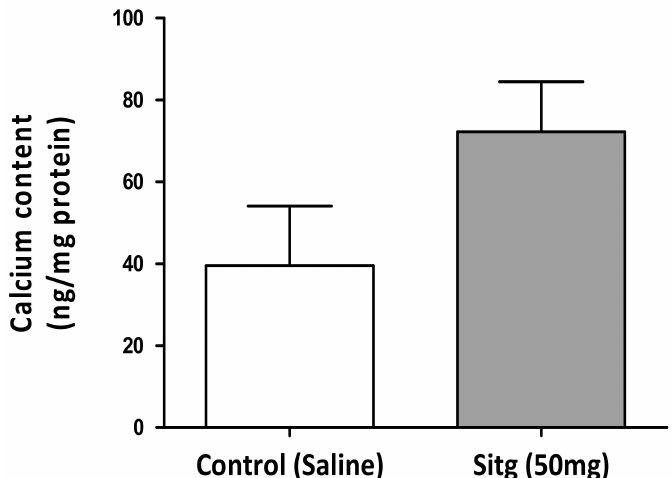
Figure 5. Changes in calcium content of cardiac tissues excised from the Sitagliptin (Sitg (50 mg); n = 7) treated animals and the Control ones ( n = 4). The bar chart displays an increase in calcium concentration in Sitg (50 mg) group, and values presented are in terms of (Mean ± SEM).